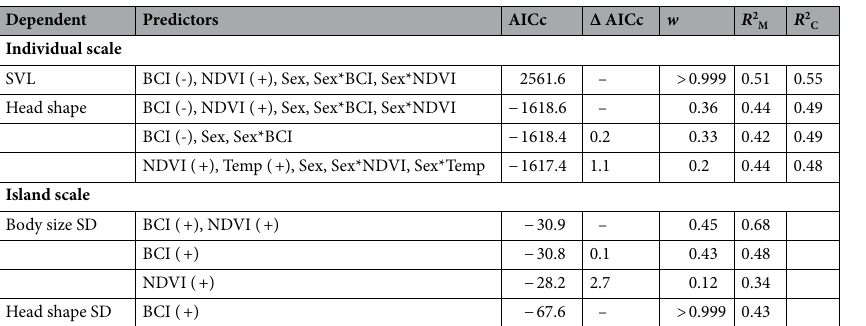
Table 1. Best models assessing the effect of environmental predictors on sexual dimorphism (SD) at individual and island scales. The dependent variables of models are: SVL; head shape; body size SD and head shape SD. Models are ranked according to their AICc values. Only models with w > 0.02 and with AICc lower than the null model are shown (see Table S2). The sign of the relationship is in parentheses. ∆AICc: difference between the AICc of a model and the best AICc; w : Akaike’s weight of the model; R 2 M : marginal R 2; R 2 C : conditional R 2